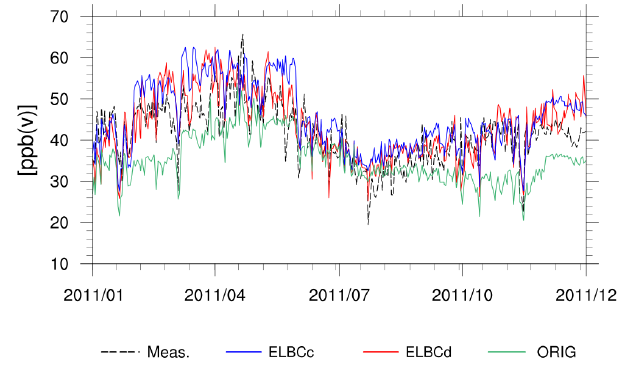
Figure 11. Same as Fig. 10, but for O 3 .